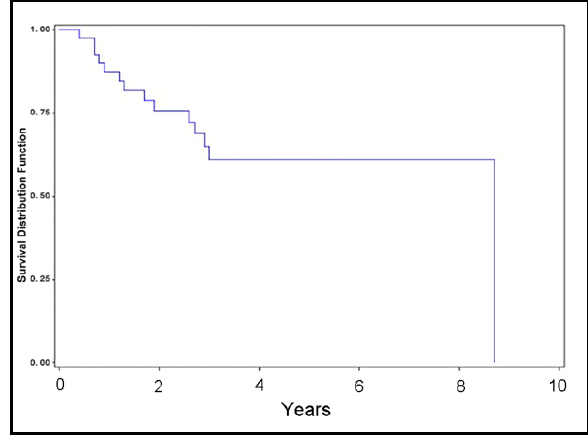
Figure 1: Kaplan Meier curve of PFS for the whole patient group Table 2 summarizes univariate analysis of PFS according to gender, BMI, primary tumor site and size, first line denosumab, site of recurrence and post- recurrence denosumab. Table 2: Univariate analysis of